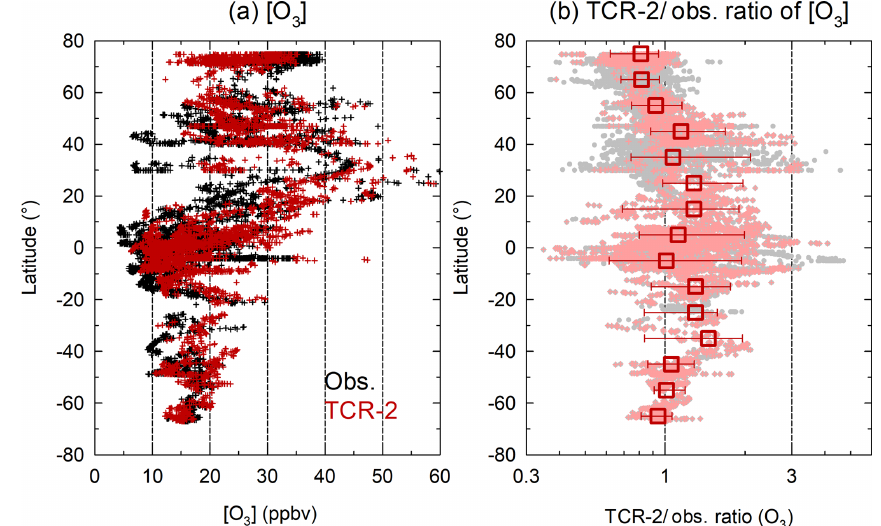
Figure 4. (a) Latitudinal distribution of O 3 mixing ratios from observation (black) and TCR-2 (red). Data are limited to cases of marine origins where difference between predicted and observed CO mixing ratios was less than 50ppbv ( N = 5647). (b) Latitudinal distribution of TCR-2 / observation ratio for O 3 (light-red dots) and binned medians (ranges are from 10th to 90th percentile) over 10 ◦ . Gray dots represent all cases without data selection.